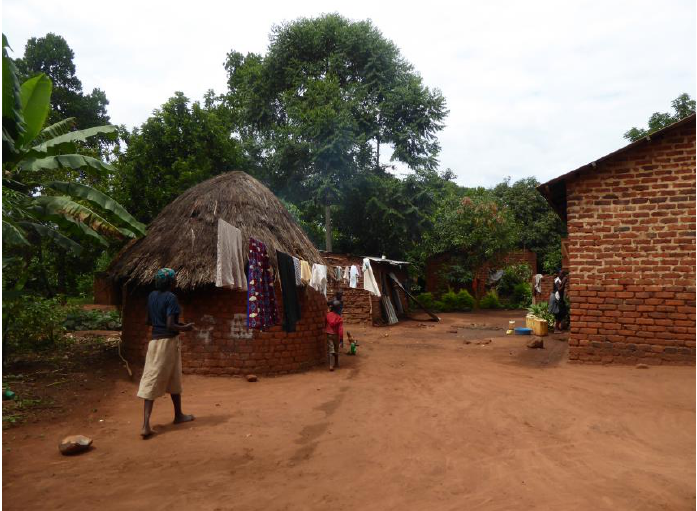
Figure 2. A typical compound in this rural area of Uganda.